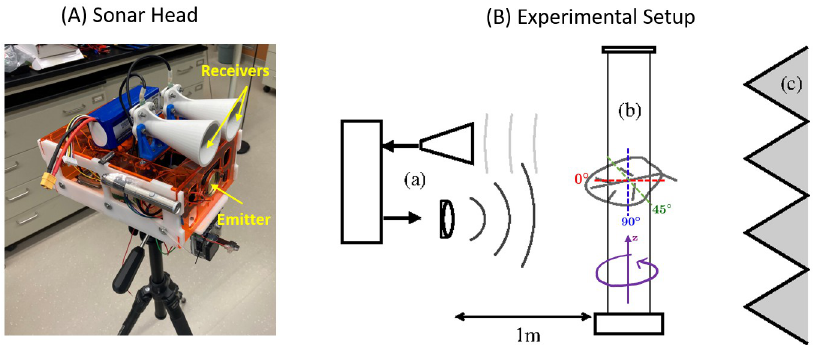
Fig 1. Experimental setup. (A) The sonar head. (B) A diagram of the experiment setup, where (a) denotes a side view of the sonar head, (b) denotes a leaf suspended on thin filament, and (c) denotes the wall of the anechoic chamber. The dashed lines show directions of vertical rotations at 0˚ (red), 45˚ (green), and 90˚ (blue). The purple arrows show the direction of horizontal